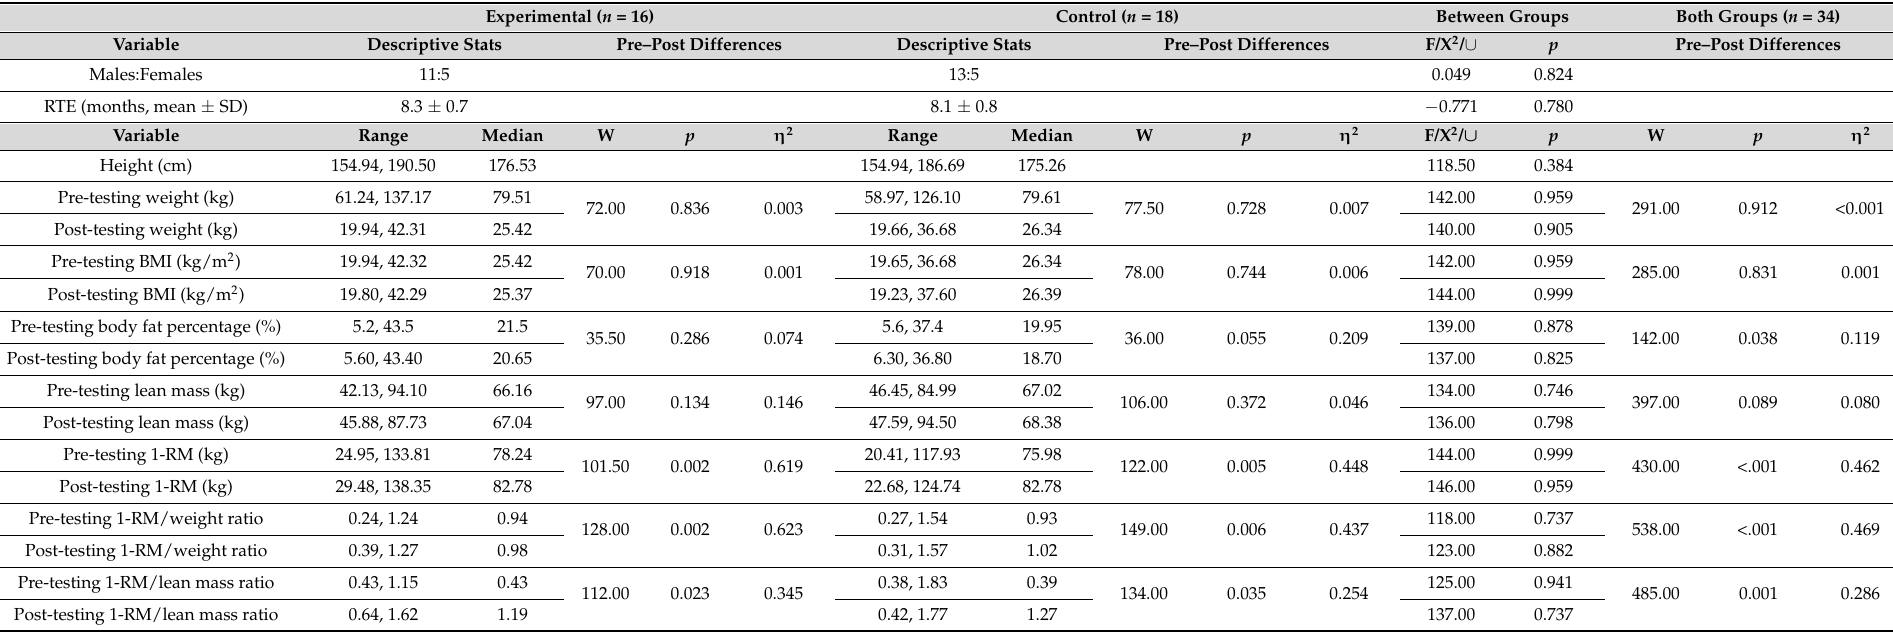
Table 1. Participant characteristics and associated statistical results. The sample size is represented by ‘n’, while the statistics used include the W statistic, the F statistic, the X 2 statistic, and the ∪ statistic. Statistical testing was performed in three separate manners: for the experimental and control groups before and after testing (the “Experimental” and “Control” columns, respectively), for both groups together before and after testing (the “Both groups” column), and between groups (the “Between groups” column). Statistical significance was thresholded at p < 0.05, and the effect size is reported as η 2 . Abbreviations: RTE = resistance training experience, 1-RM = one-repetition